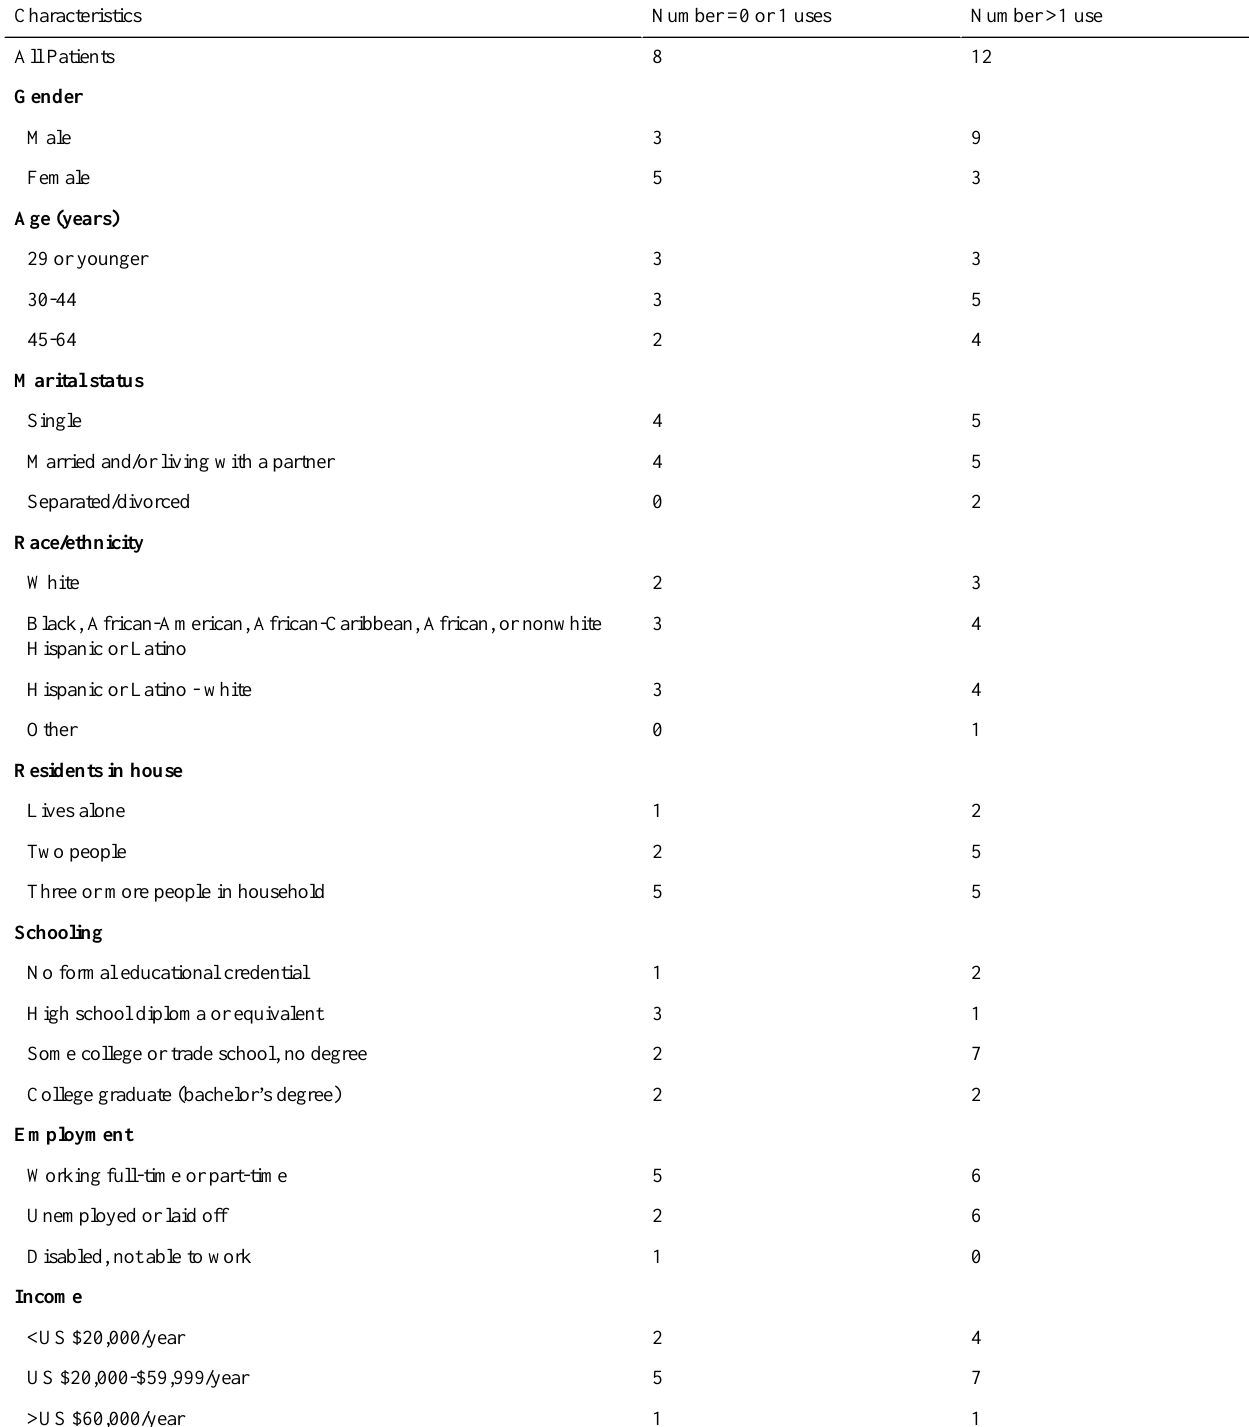
Table 1. Patient